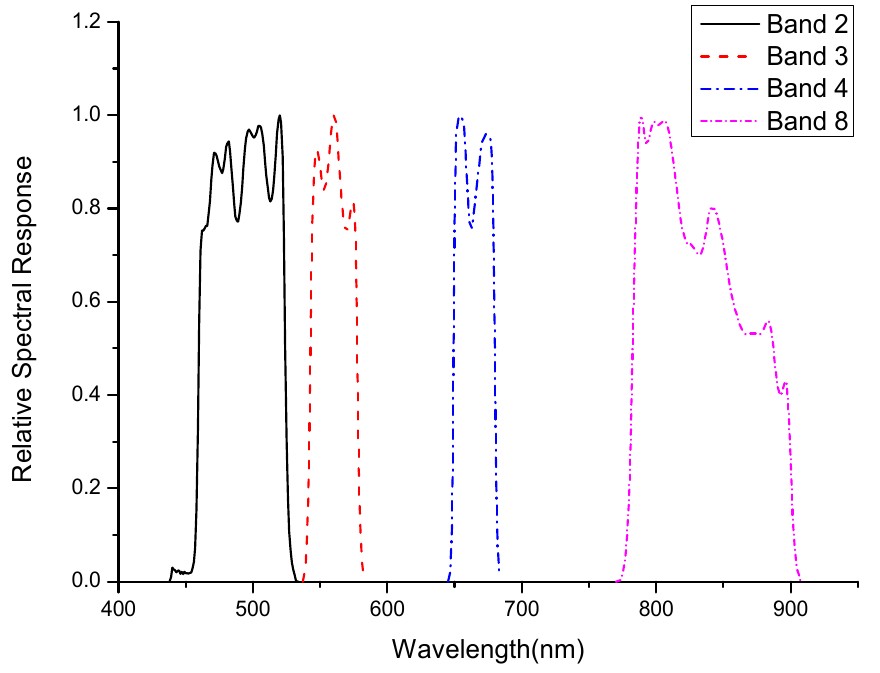
Figure 9. Sentinel-2A relative spectral response.